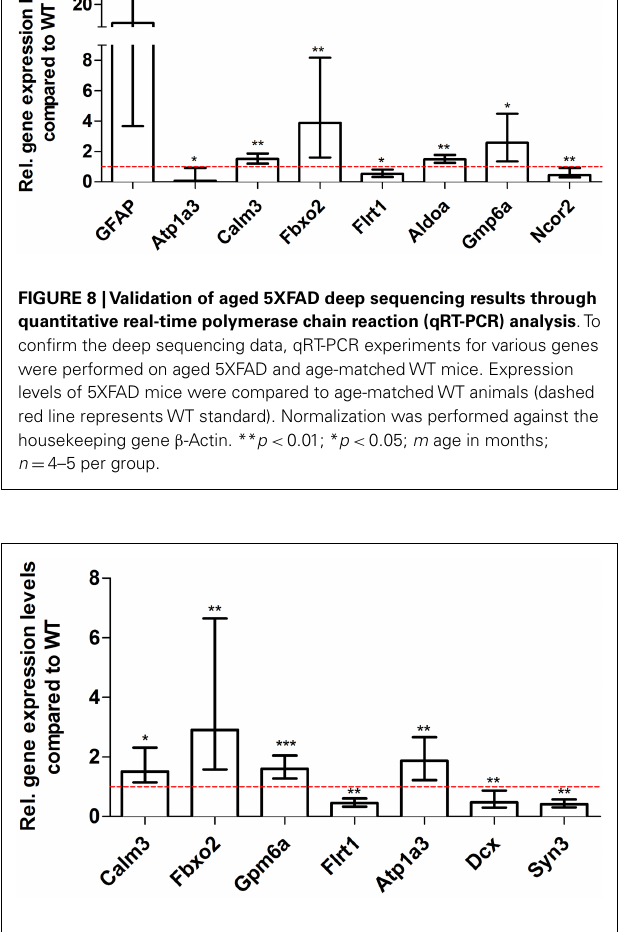
FIGURE 9 |Validation of agedTg4–42 deep sequencing results through quantitative real-time polymerase chain reaction (qRT-PCR) analysis .To confirm the deep sequencing data, qRT-PCR experiments for various genes were performed on agedTg4–42 and age-matchedWT mice. Expression levels ofTg4–42 mice were compared to age-matchedWT animals (dashed red line representsWT standard). Normalization was performed against the